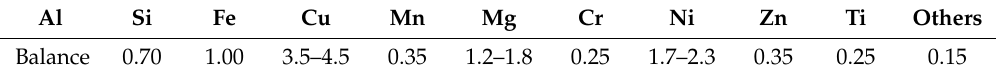
Table 1. Chemical composition of A-242 aluminium alloy